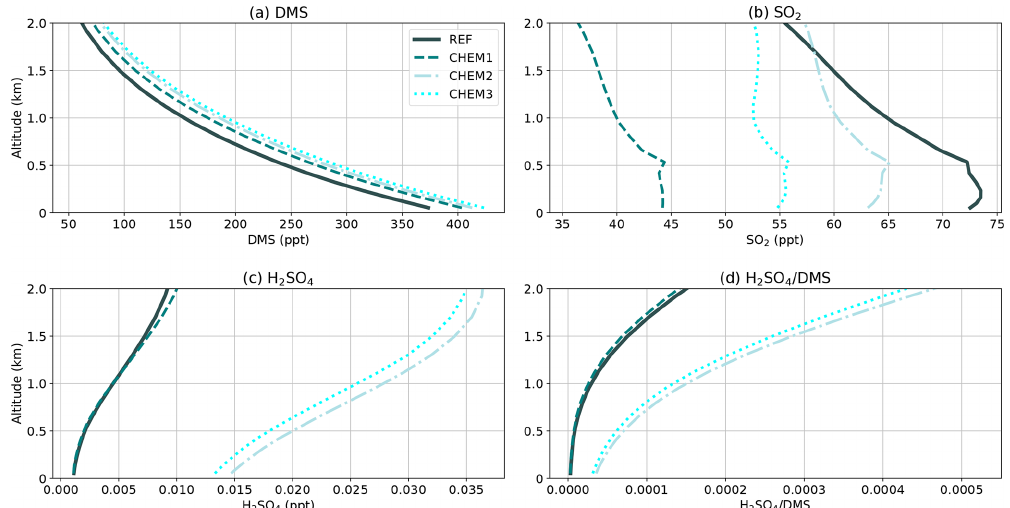
Figure 7. Vertical profiles of trace gas mixing ratios between 40 and 60 ◦ S in the lowest 2km of the atmosphere for the REF and CHEM simulations. All quantities are climatological means for DJF. (a) DMS; (b) SO 2 ; (c) H 2 SO 4 ; (d) the ratio of H 2 SO 4 / DMS.